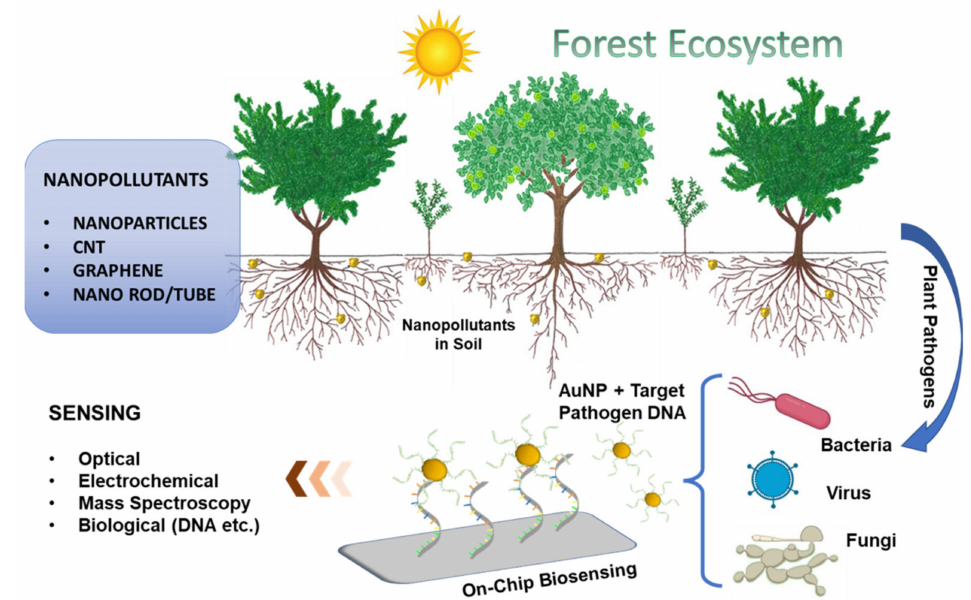
Figure 1. Schematic presentation nanomaterial pollution and use of nanomaterial for plant pathogen